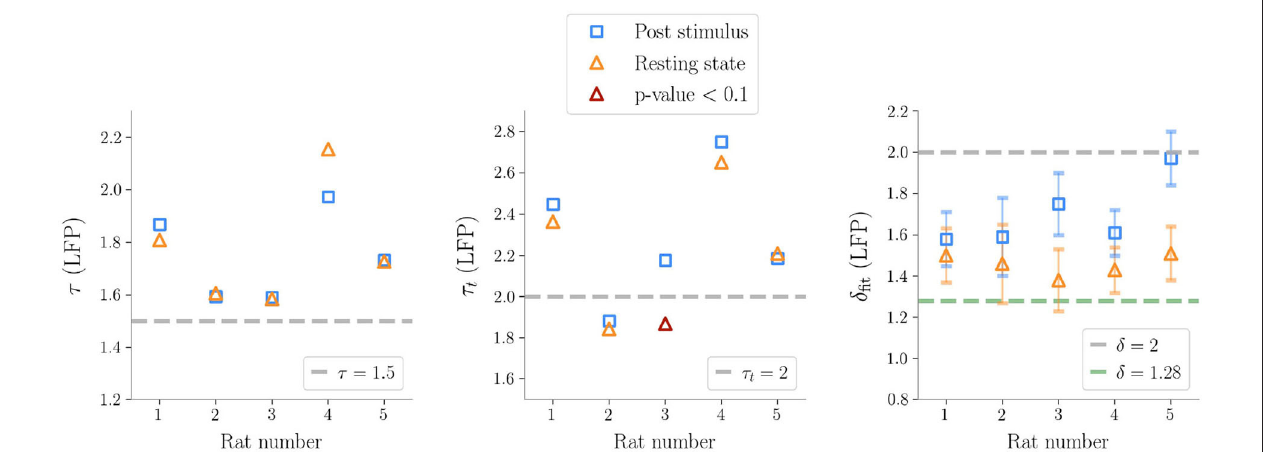
FIGURE 3 | Exponents obtained after subsampling in Local Field Potential data ( τ is the exponent for the sizes, τ t for the durations, δ fit is the fitted exponent from S(T) ∼ T δ fit ). The exponents predicted by the critical branching process are shown in the plot as gray dashed lines. The line δ = 1.28 is also plotted, which is reported in Fontenele et al. (2019) as a universal exponent found in many different experiments. It is noteworthy that, as seen in the plot on the right, the exponents δ fit are always far from the hallmark of the branching process, except for one case after stimulation, where the presence of large bumps in the size distribution makes the slope of the line in the ( h S ( T ) i , T ) plane